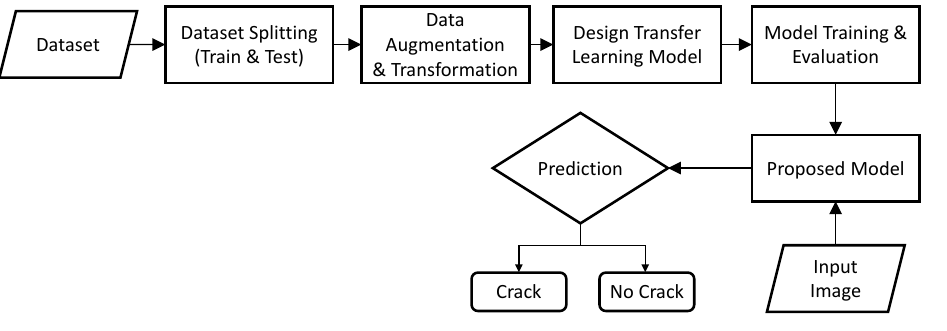
Figure 1. A block diagram of the proposed